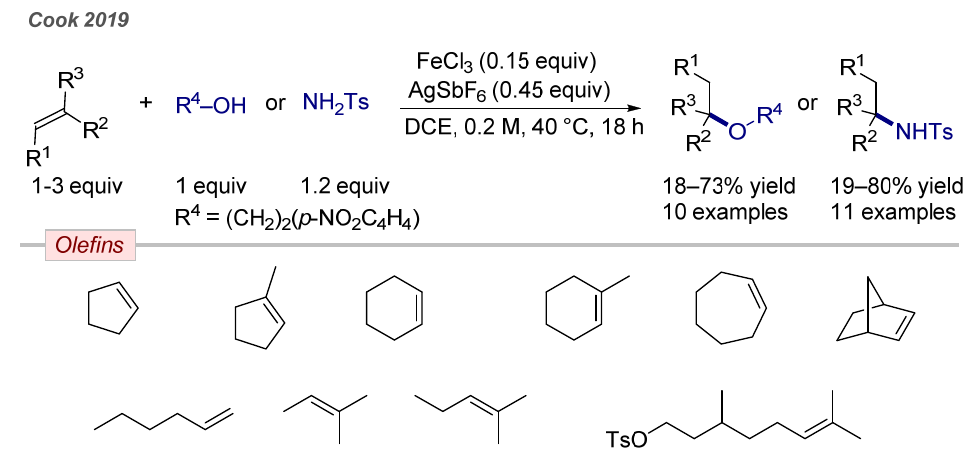
Figure 5. Intermolecular hydrofunctionalization of mono-, di- and trisubstituted olefins with 2-(4- nitrophenyl)-ethanol and p -toluenesulfonamide catalyzed by the combination FeCl 3 /AgSbF 6